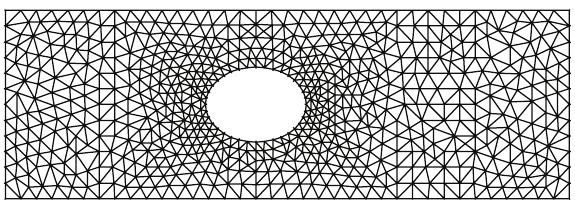
Figure 1: Case 1: finite element mesh for the target curve.